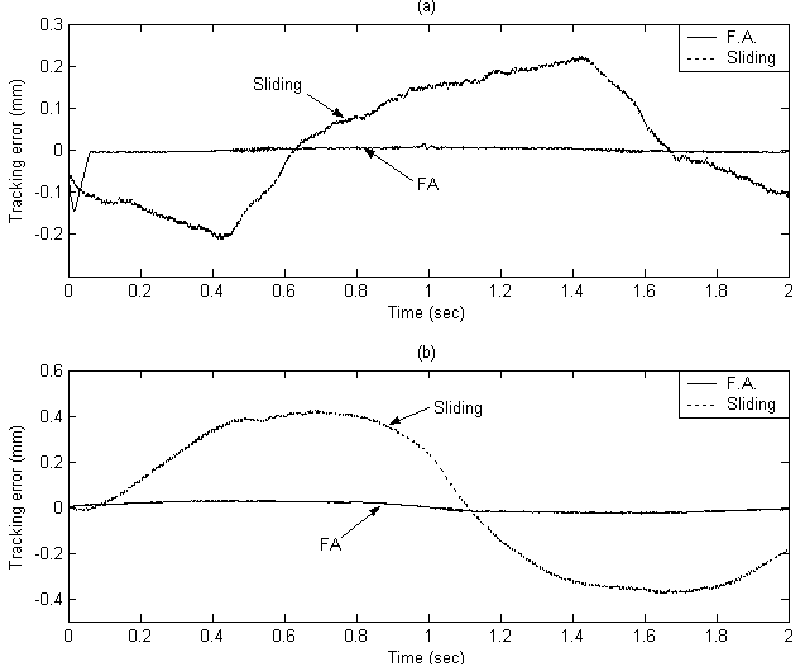
Figure 7. The tracking error of (a) X axis and (b) Y axis (case